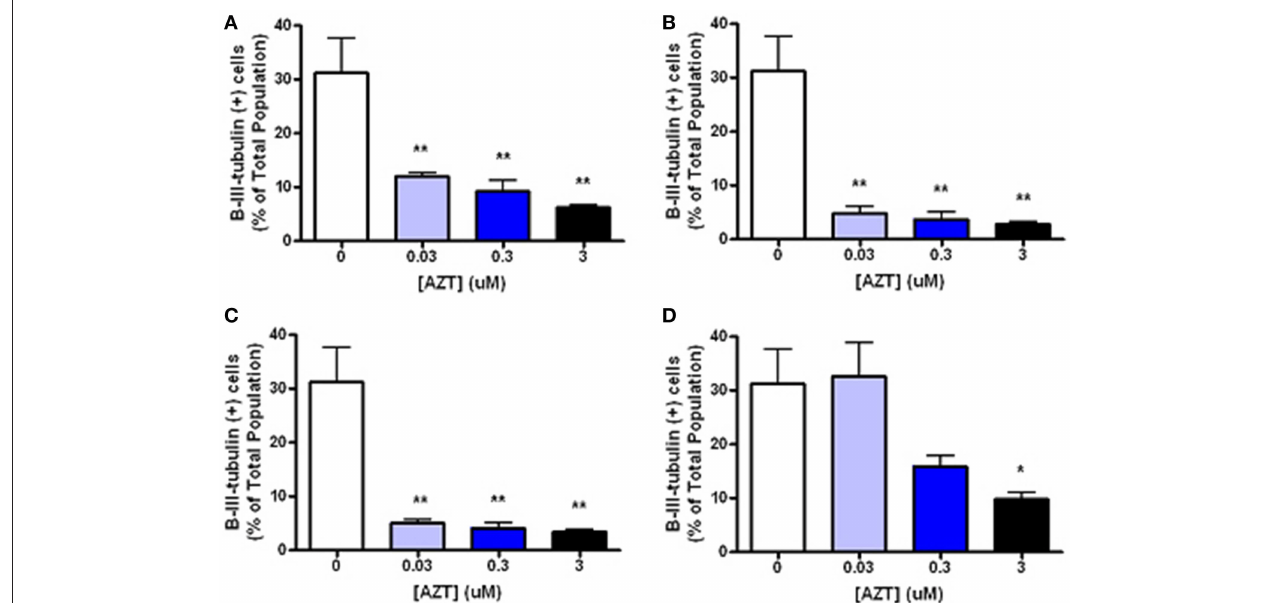
FIGURE 5 | Short, low-dose AZT exposure at the time of withdrawal is sufficient to perturb inducible neurogenesis. At the initiation of serum and mitogen withdrawal MASCs were treated with a single pulse of 0.03, 0.3, or 3 µ M AZT for 2, 8, or 24h ( A – C , respectively). All AZT doses suppress neuroblast induction in a dose- and time-dependent manner. Even the lowest concentration of AZT, 0.03 µ M, applied for only 2h at the time of serum and mitogen withdrawal significantly decreases neuroblast formation compared